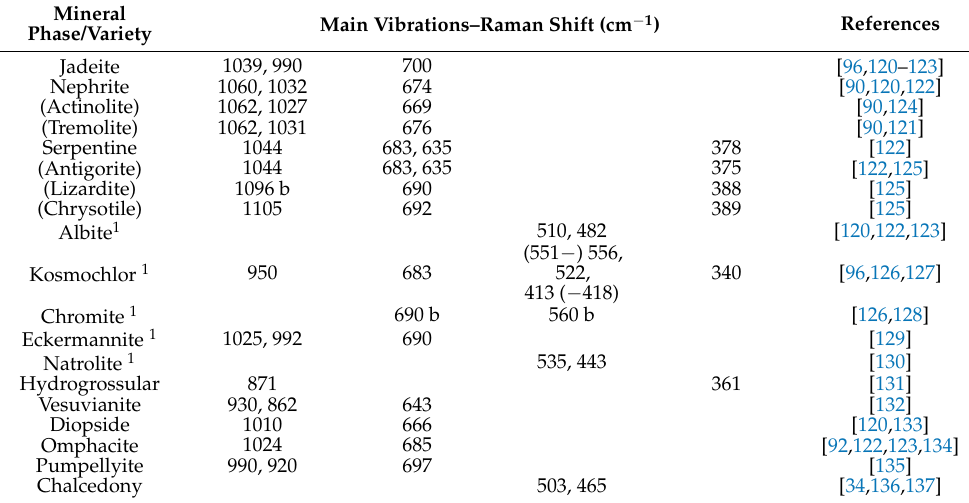
Table 4. Raman main features characterizing Green Stones. The main bands of pure actinolite, tremolite phases, together with those of nephrite, and antigorite, lizardite, chrysotile phases, together with those of serpentine, have been reported as references for